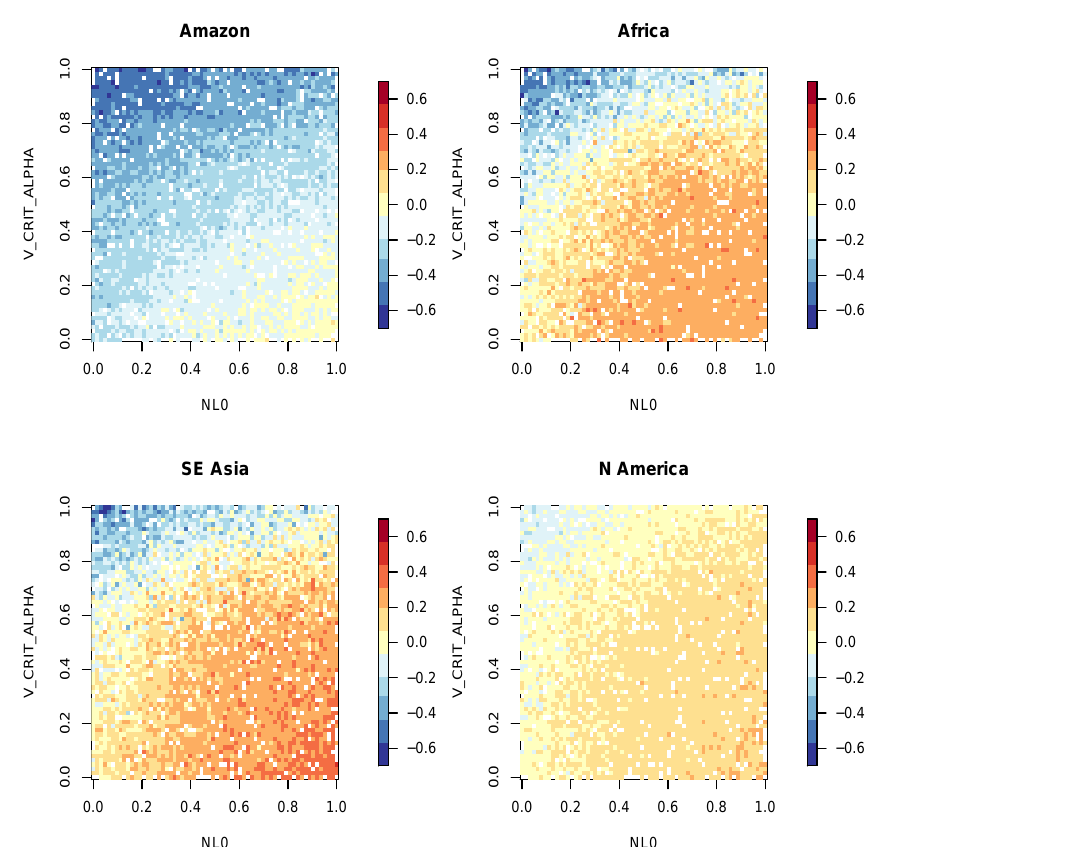
Figure 8. Maps of simulator error, in units of forest fraction, when projected into the two-dimensional space of the most active parameters, NL0 and V_CRIT_ALPHA.